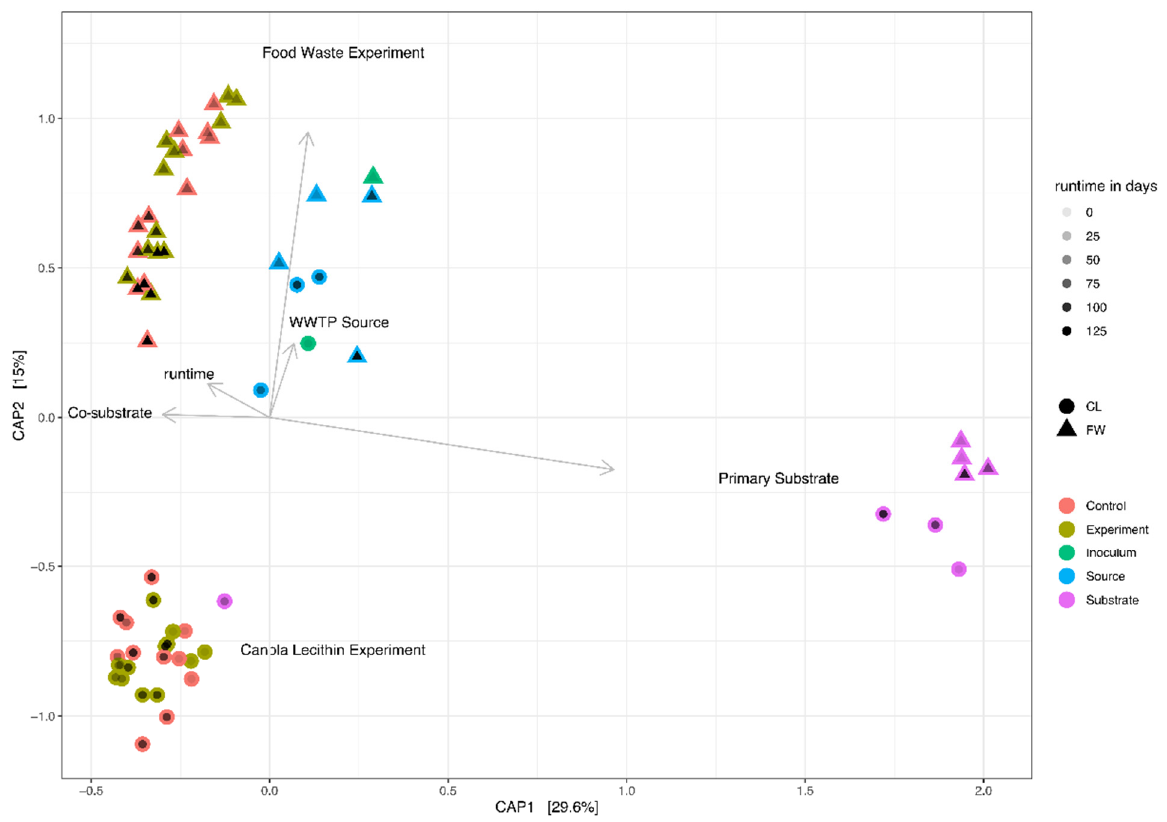
Figure 4. Constrained ordination plot (CAP) of the MCC of the two experiments, with environmental factors added. The ordination is a combination of shape and color to represent the operational treatment and the corresponding PWASS batch simultaneously, as a third dimension. MCC from both experiments, food waste (FW, triangles) and canola lecithin (CL, circles), are shown with environmental predictors, identified as significant in the Permanova on top of the ordination. Runtime is added to each point with alpha shading from light to dark, black symbols being the maximum runtime during each experiment.